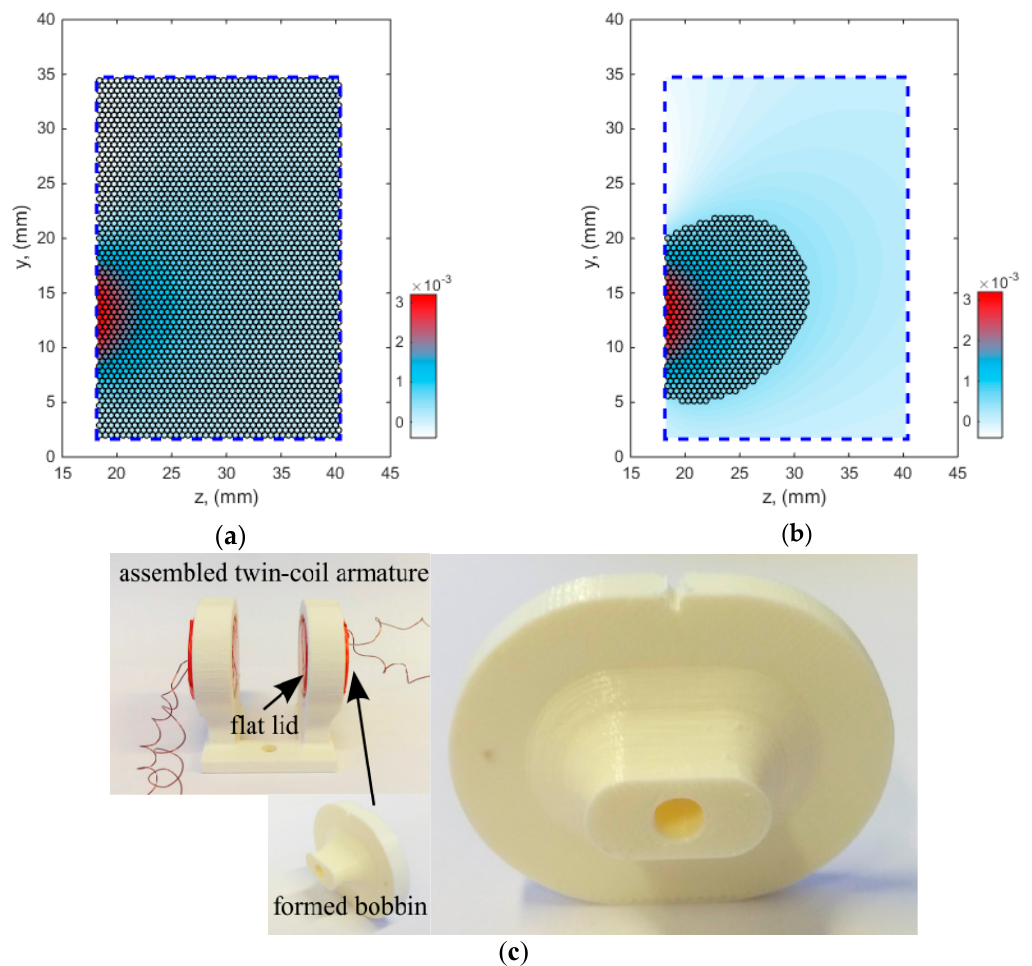
Figure 4. Results of optimization: distribution of turns over coil cross-section plane (see Figure 2) before ( a ) and after optimization ( b ). Dashed line denotes assumed area w × h with r c = 2 mm, and w , h and δ equal to 22, 33 and 0.01 mm, respectively. Colormap displays distribution of quantity (2) in V ∙ s/m. c) Assembled armature using a 3d-printed coil carcass including formed bobbin and flat lid so as to obtain the distribution of turns shown in Figure 4b. The coils in the physical system are connected in parallel.